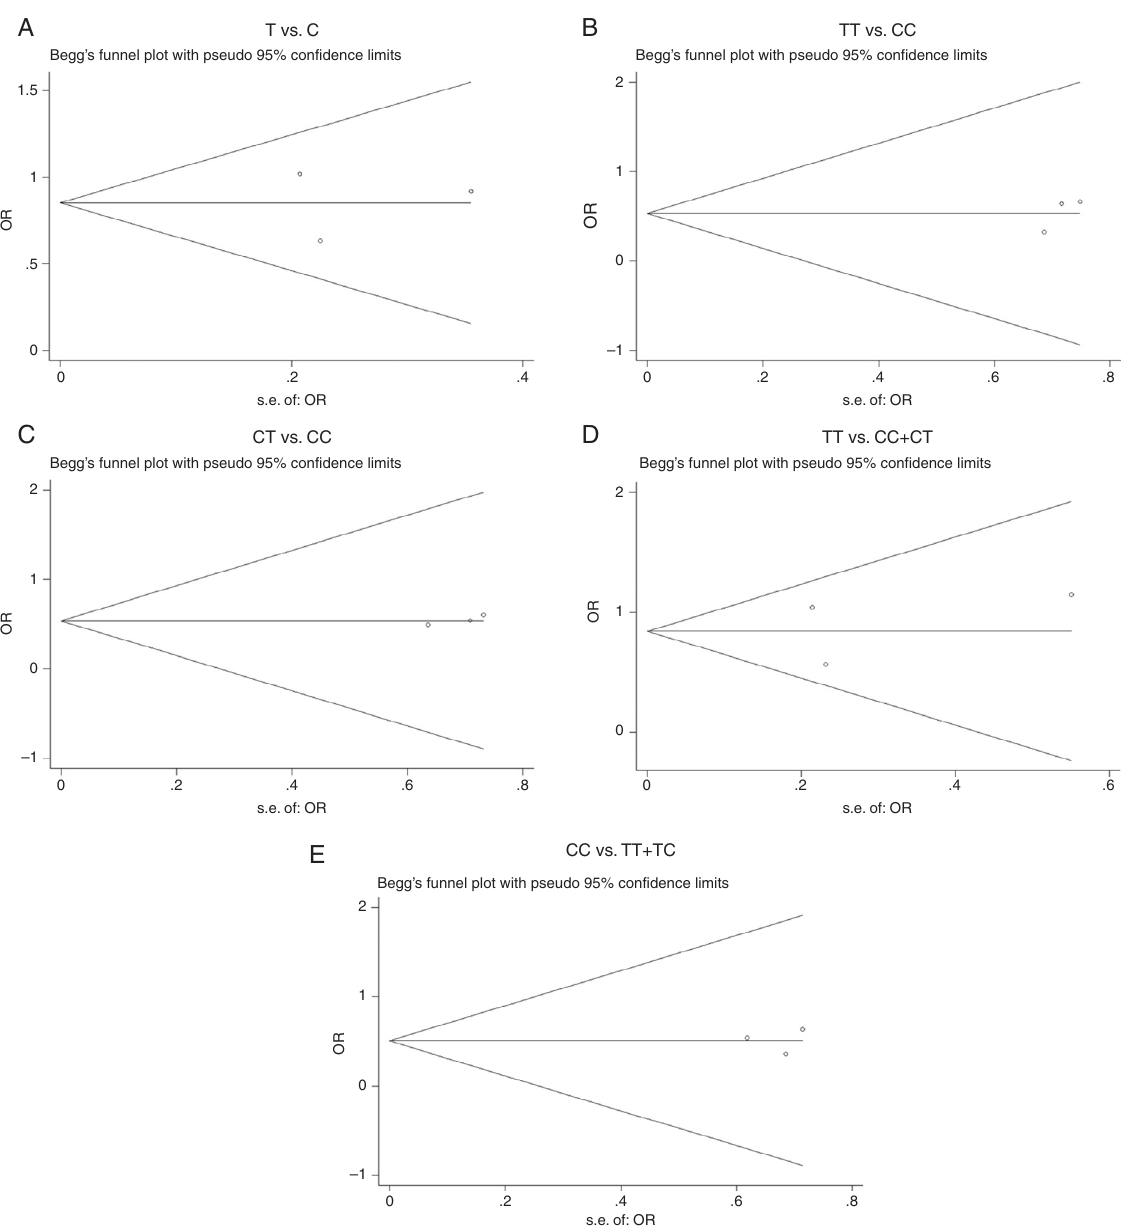
Begg’s funnel plot for the superoxide dismutase 2 (SOD2) C47T polymorphism and noise induced hearing loss (NIHL). Allele model, T vs . C (A); co-dominant model, TT vs . CC (B); CT vs . CC (C); recessive model, TT vs . CC + CT (D); dominant model, CC vs . TT + TC (E). logor, odds ratio logarithm; s.e., standard error. allele model (T vs . C, p = 1.00), dominant model (CC vs .